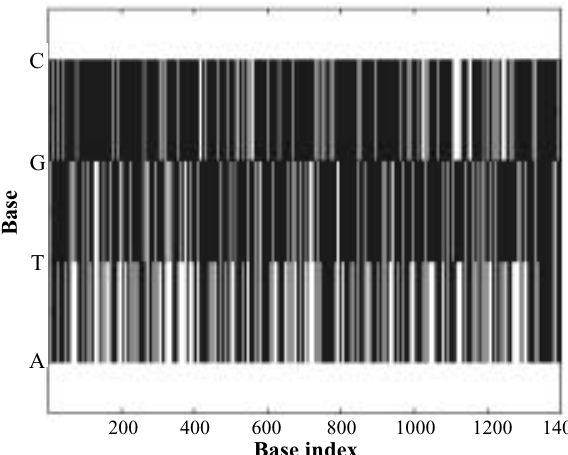
Figure 6 BWT analysis of the synthetic DNA sequence based on adaptive mapping.